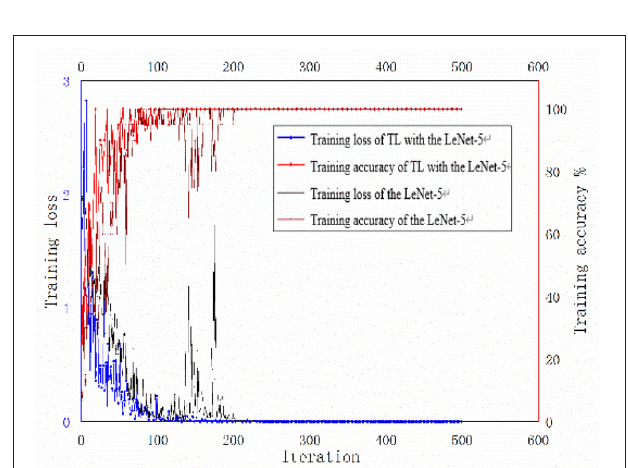
FIGURE 11 | Training accuracy and loss of transfer learning with the LeNet-5 method and the traditional LeNet-5 method under a complex environment for the target